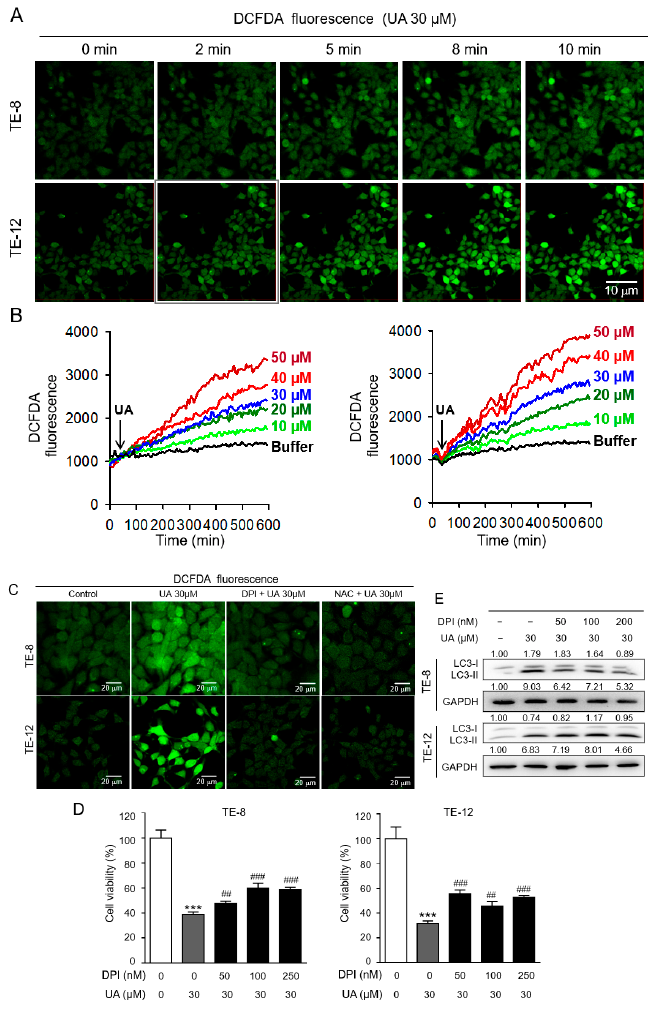
Figure 5. Ursolic acid induced autophagy by reactive oxygen species (ROS) induction in ESCC. ( A ) The UA-induced ROS-mediated DCFDA fluorescence intensity of the cells treated with UA (30 µM) increased in a time-dependent manner. ( B ) The quantitative analysis of ROS by fluorescence-activated cell sorting showed increased DCFDA fluorescence in a dose-dependent manner. ( C ) DPI- and NAC-treated cells showed decreased fluorescence intensity, demonstrating intracellular ROS inhibition. ( D ) Combination treatment with the ROS inhibitor DPI increased cell viability compared with UA treatment alone. ( E ) TE-8 and TE-12 cells were treated with 30 µ M UA and 100 nM or 250 nM DPI. We detected LC3 protein levels by Western blot analysis and employed GAPDH as an internal control. The data are presented as the mean ± SE for three independent experiments.*** p < 0.001 compared with the control, ## p < 0.01, and ### p < 0.001 compare with the UA-treated